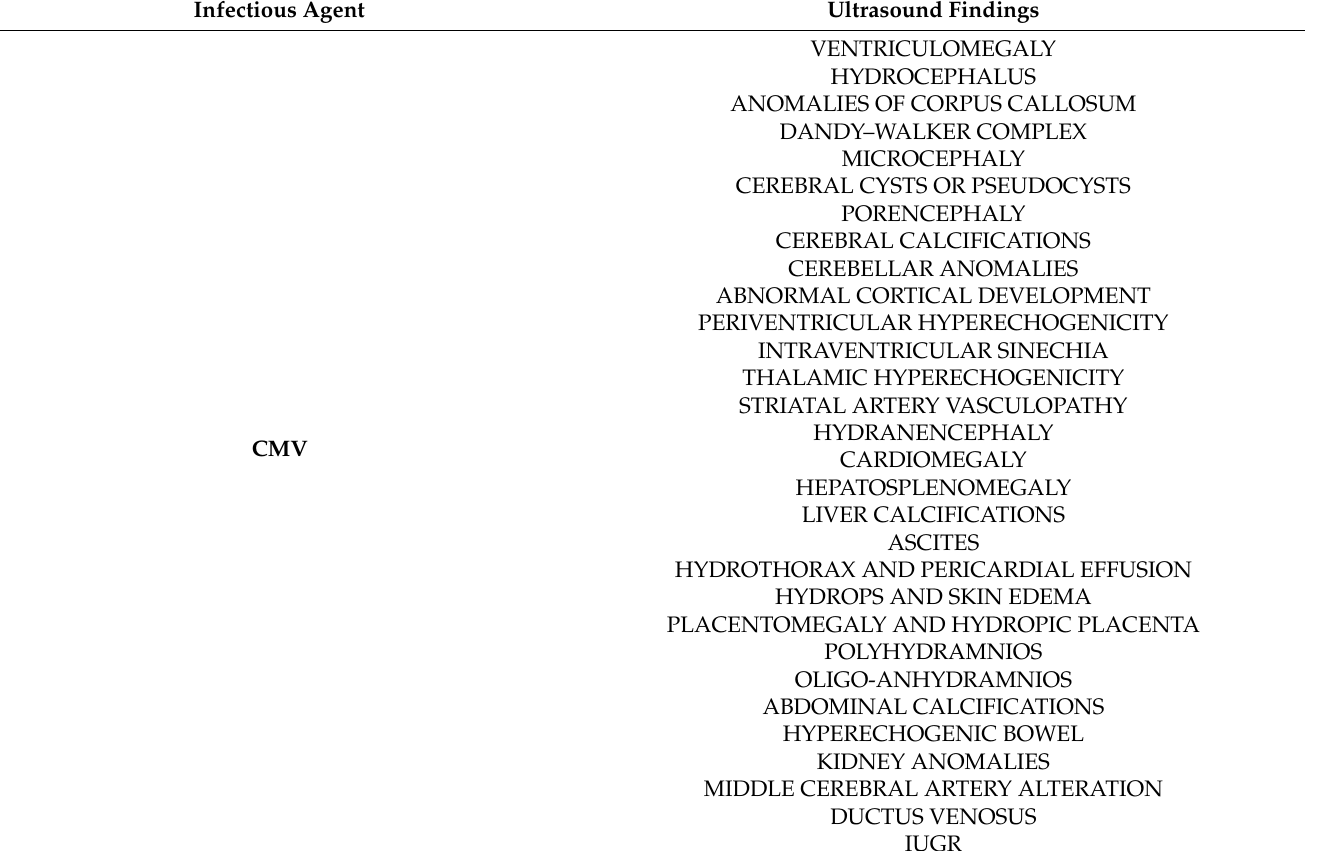
Table 2. Association between the pathogens and the corresponding fetal US